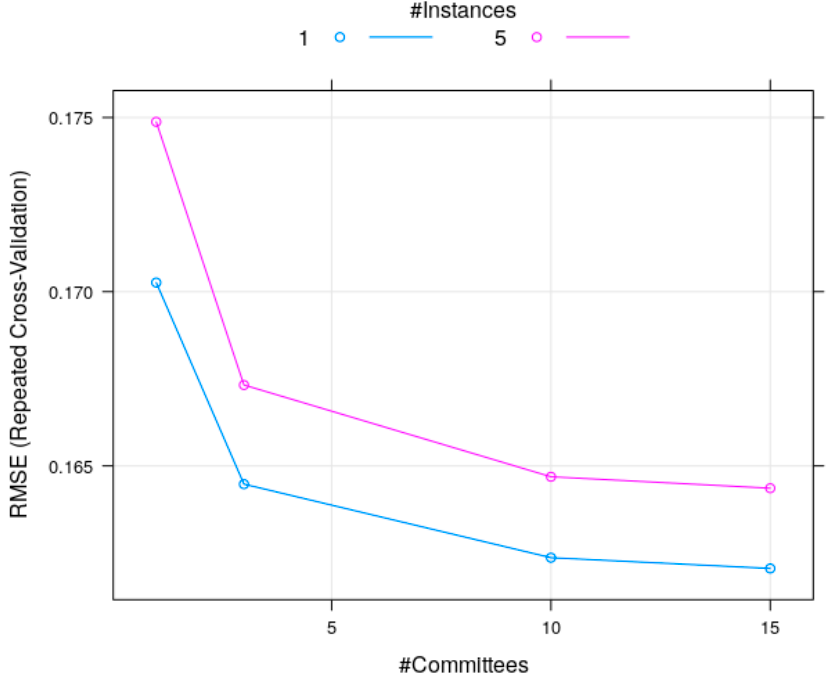
Figure 8. Computation of the prediction errors (RMSEs) for each validation set withheld in repeated cross-validation under various model parameters.